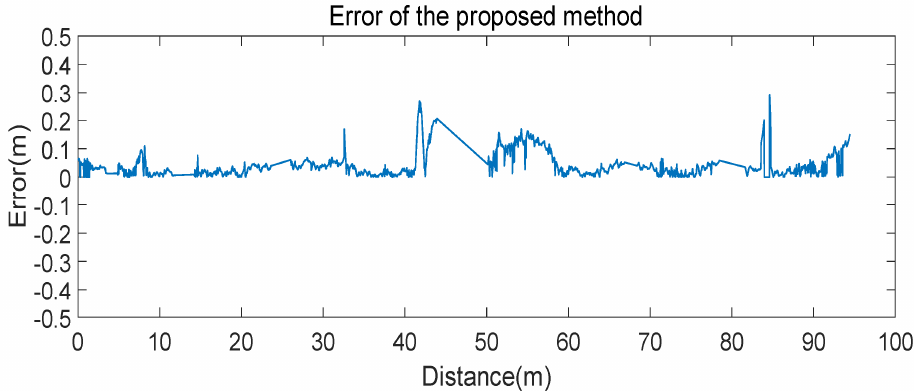
Figure 20. The blue line indicates the errors in different positions. Due to missing sections of NAV350 trajectory, there are sudden changes near several errors. Most errors are less than 0.1 m.